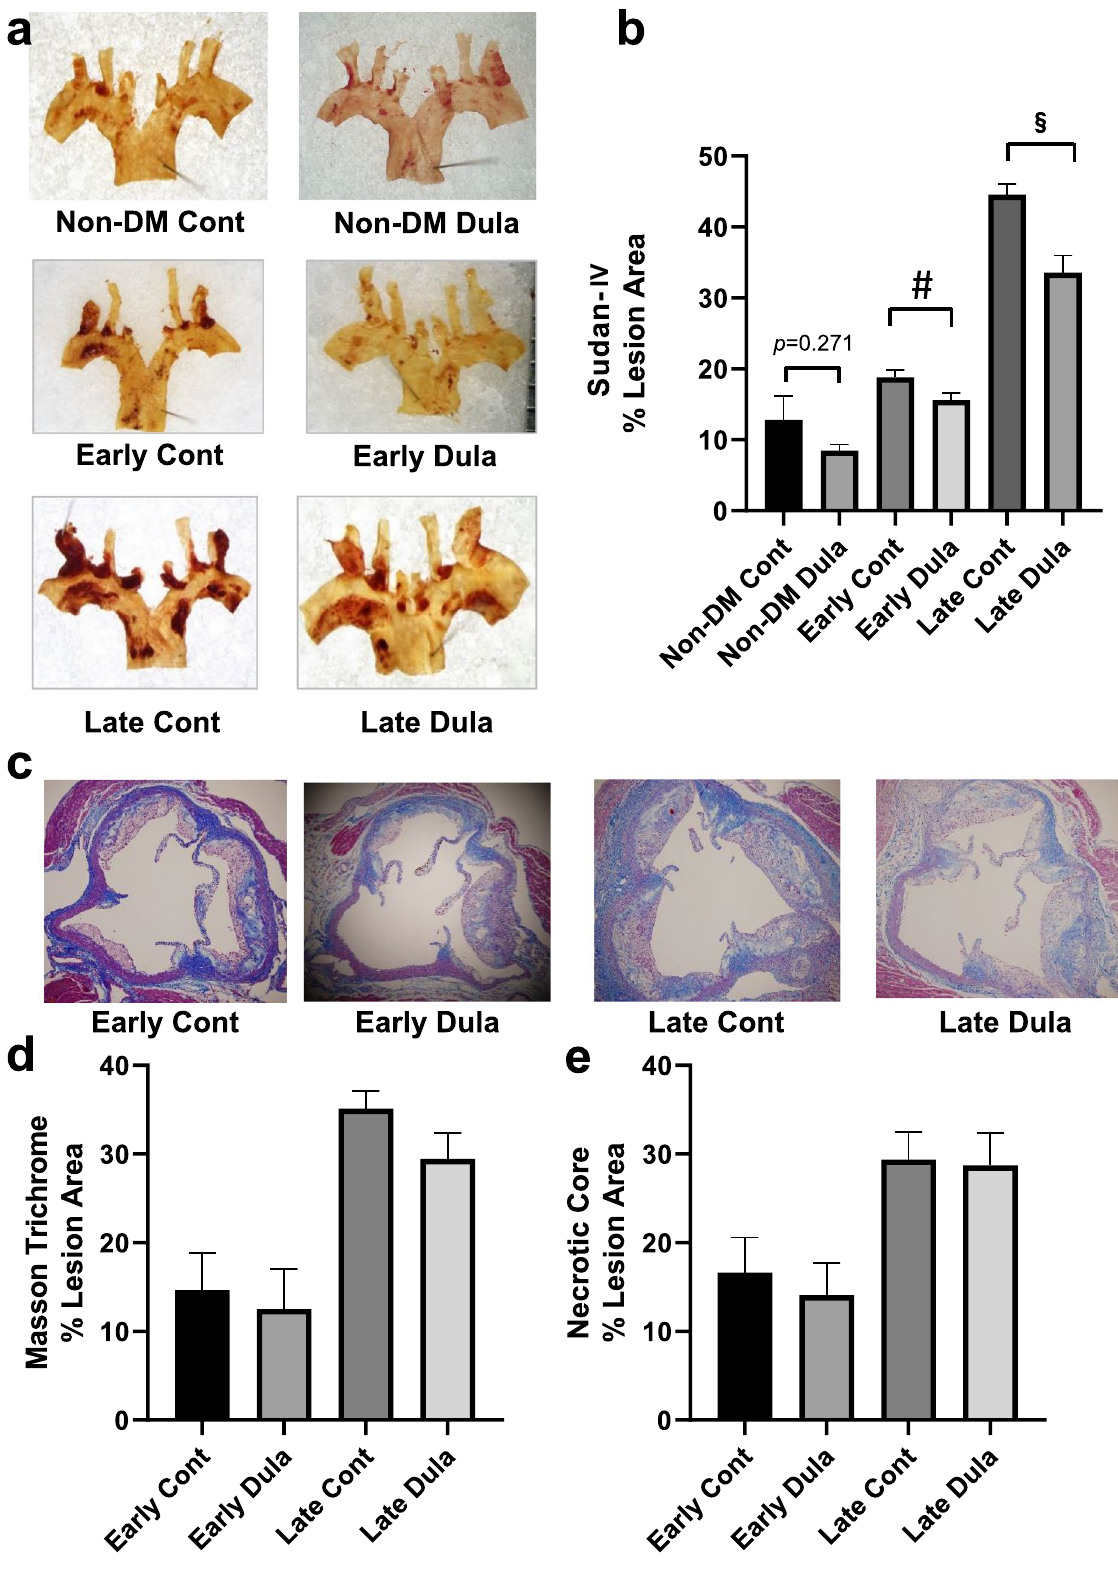
Figure 2. Atherosclerotic lesion in aortic arch and Masson trichrome staining of aortic root in ApoE knockout mice. ( a ) Representative Sudan-IV staining pictures in aortic arch. ( b ) Sudan-IV positive area (% lesion area) ( c ) Representative Masson trichrome staining pictures in aortic root. ( d ) Masson trichrome staining (% lesion area). ( e ) Necrotic core in aortic root (% lesion area). Non-DM Cont (n = 7), non-DM Dula (n = 6), Early Cont (n = 5–6), Early Dula (n = 5 ~ 6), Late Cont (n = 6), Late Dula (n = 6). Values are the mean ± SEM of data obtained from each group. # p < 0.05 (Early Cont vs Early Dula), § p < 0.05 (Late Cont vs Late